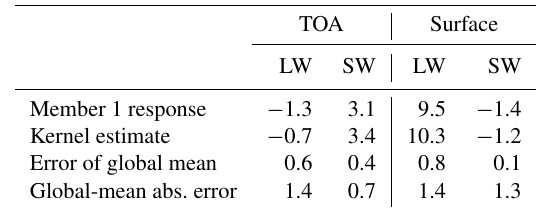
Table 1. Top-of-atmosphere (TOA) and surface clear-sky radiative responses (Wm − 2 ) for 2096–2006 from CESM1 large-ensemble member 1 (from which the kernels are derived) and the estimated radiative fluxes using the kernels and radiative forcing. TOA Surface LW